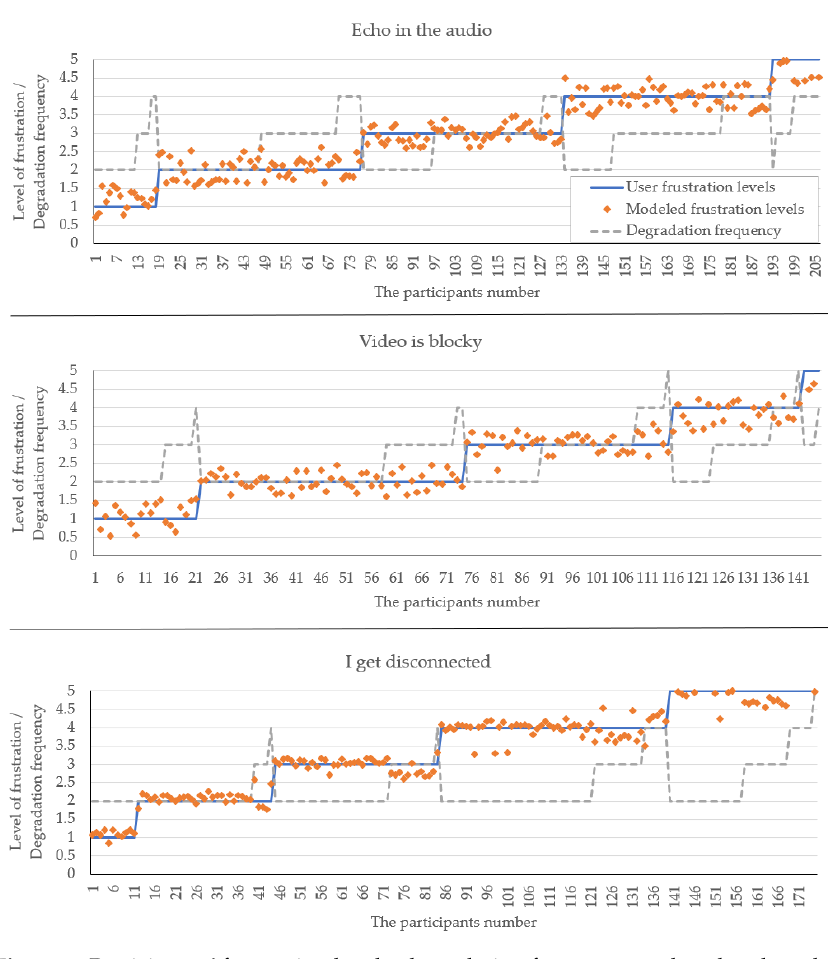
Figure 6. Participants’ frustration levels, degradation frequency, and updated modeled frustration levels (after introducing UFSI) for three quality degradation types.